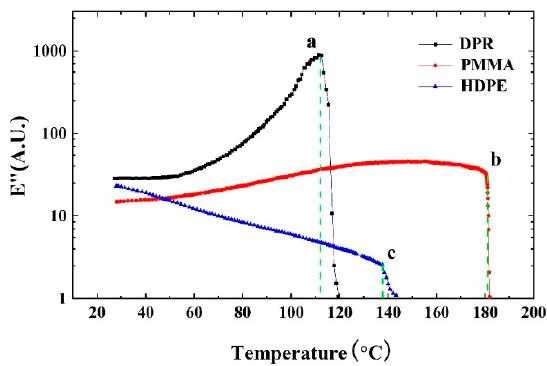
Figure 5. E ″ of disproportionated rosin (DPR), polymethyl methacrylate (PMMA), and high-density polyethylene (HDPE) microwire modified QTF as a function of temperature.